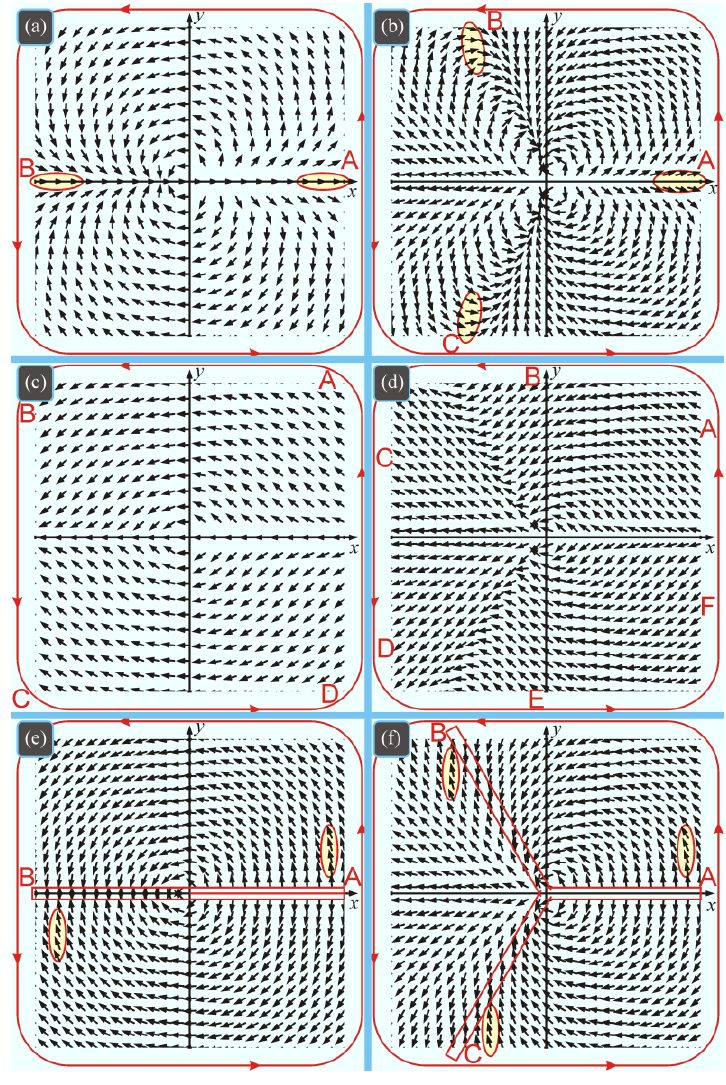
Figure 6. Jones vectors of field (25) of orders ( a , c , e ) ( n = 2) and ( b , d , f ) ( n = 3) at a = 1/2 ( a , b ), a = 3/2 ( c , d ), and a = 1 ( e , f ). Ellipses mark regions where the polarization vector is directed ( a , b ) to the right or ( e , f ) upwards. Letters A, B, C, D, E, and F mark segment boundaries for a contour along which the field vector tilt to the x -axis increases or decreases. Rectangles mark V-lines ( e , f ).